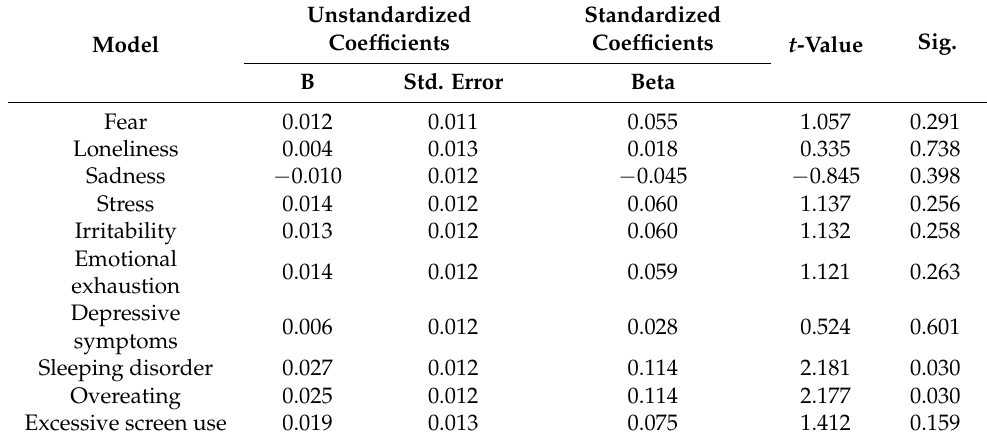
Table 3. Regression analyses of perception of the ten psychological